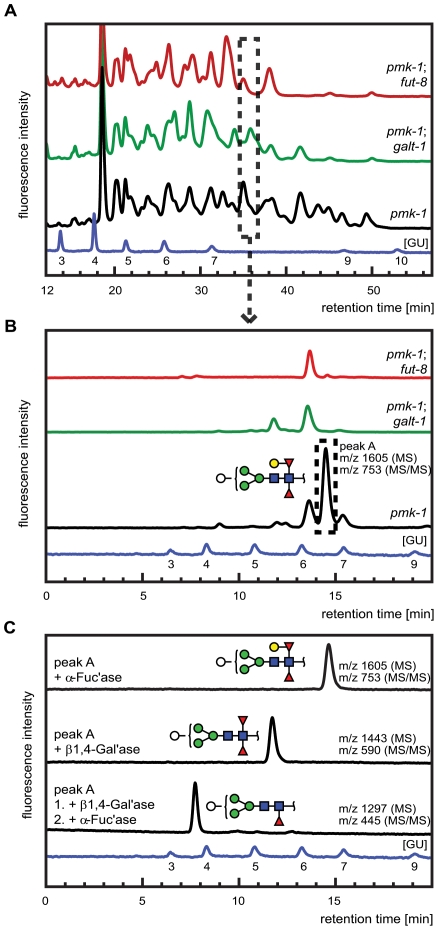
Comparative analysis of the N-glycome in CGL2-resistant C. elegans double mutants pmk-1;fut-8(op498) (red trace) and pmk-1(km25);M03F8.4(op497) (green trace) and the isogenic CGL2-hypersensitive single mutant strain pmk-1(km25) (black trace).(A) and (B) HPLC of released and fluorescently labeled N-glycans. Upon enzymatic release (here the PNGase F resistant, but PNGase A sensitive glycome fraction is shown) and fluorescent labeling, N-glycans were separated by normal phase HPLC and analysed by mass spectrometry (A). Fractions at similar retention times (e.g., dashed rectangle) were further separated by reversed phase HPLC and the resulting pure glycans were analysed by mass spectrometry (MS) and for selected fractions by MS/MS (B). (C) Structural characterization of a selected isolated peak. Peak A found in the pmk-1 strain but not in the two double mutant strains was treated with β1,4-galactosidase (β1,4-Gal'ase) and α-fucosidase (α-Fuc'ase). The reaction products were analysed by reversed phase HPLC and MS and MS/MS (see Supplementary Figure S2). The blue HPLC trace represents the glycan standard in glucose units (GU). Monosaccharides are represented as symbols: Man (green circle), Gal (yellow circle), GlcNAc (blue square), Fuc (red triangle), Hex (white circle).